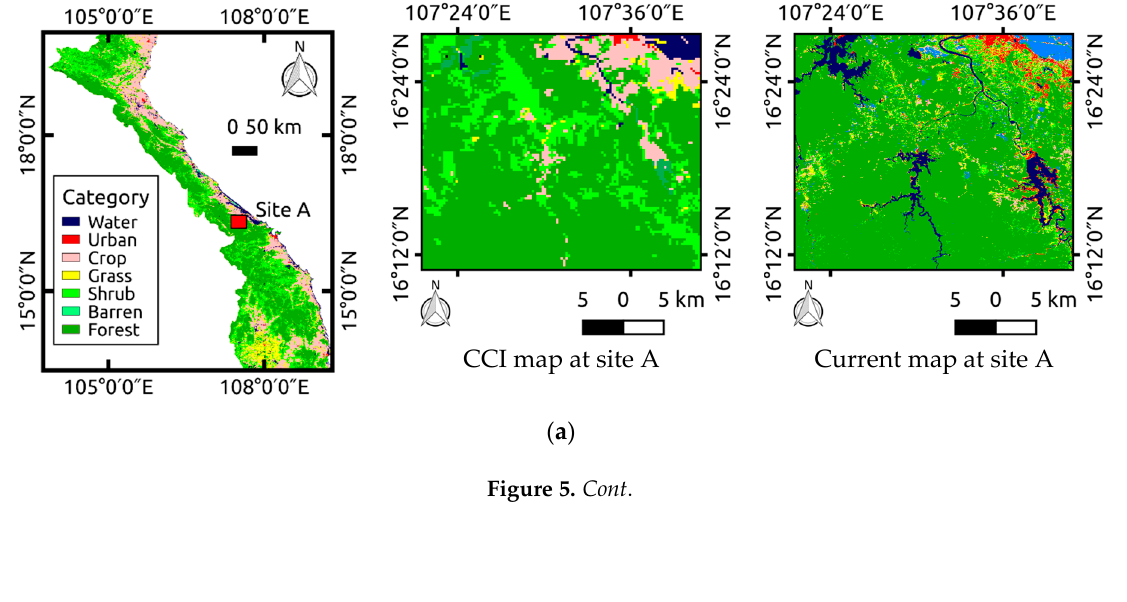
Figure 4. A comparison of our maps and previous global land cover maps in the spatial resolution ( a ) and in the overall accuracy ( b ) over Central Vietnam.